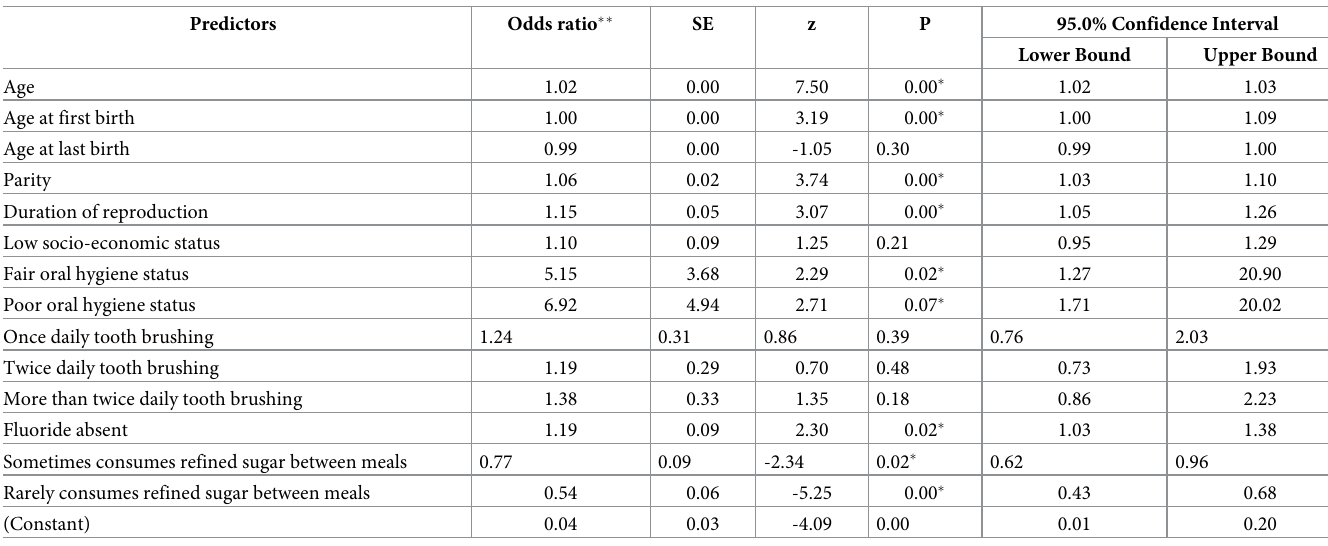
Table 5. Multiple regression for predictors of